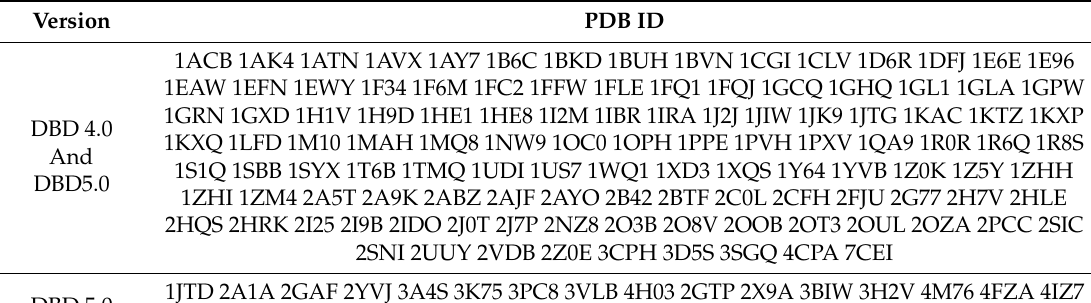
Table 6. 138 dimers used in this